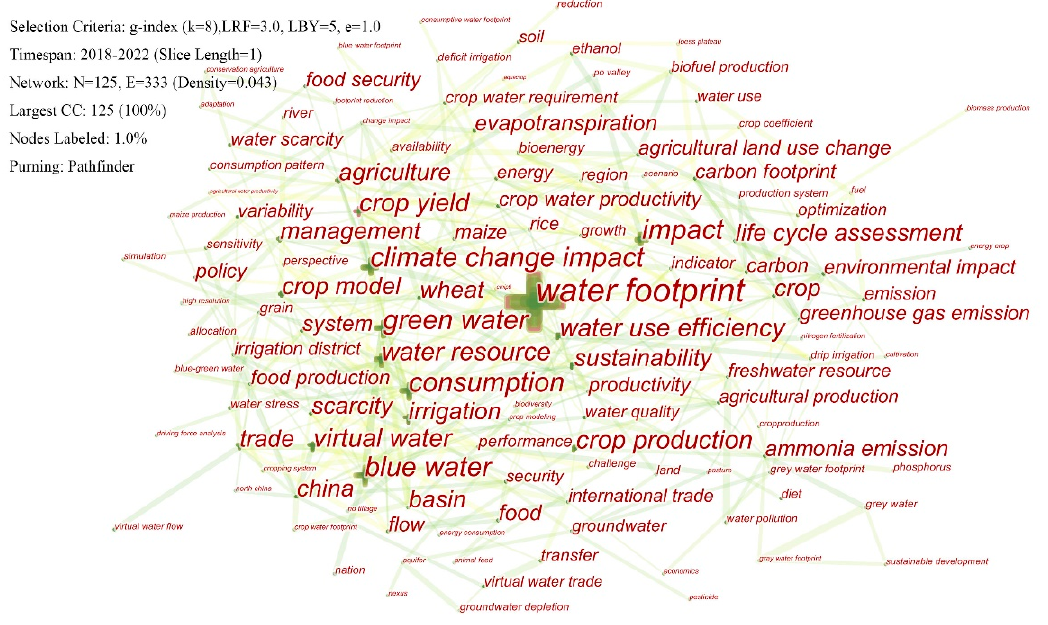
Figure 7. Co-occurrence network of keywords 2012–2017.